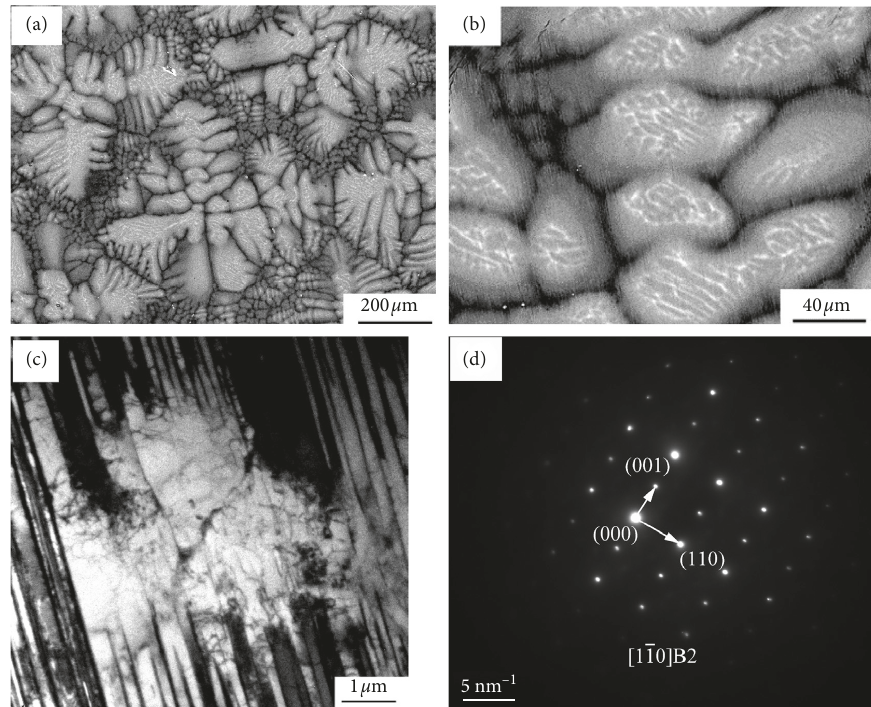
Figure 3: Microstructures of transverse section of the mushy zone for the 30 μ m/s withdrawn DS ingot: (a) low-magnification BSE image; (b) high-magnification BSE image; (c) TEM image of the white zone in (b); (d) SAD pattern of B2 phase in (c).